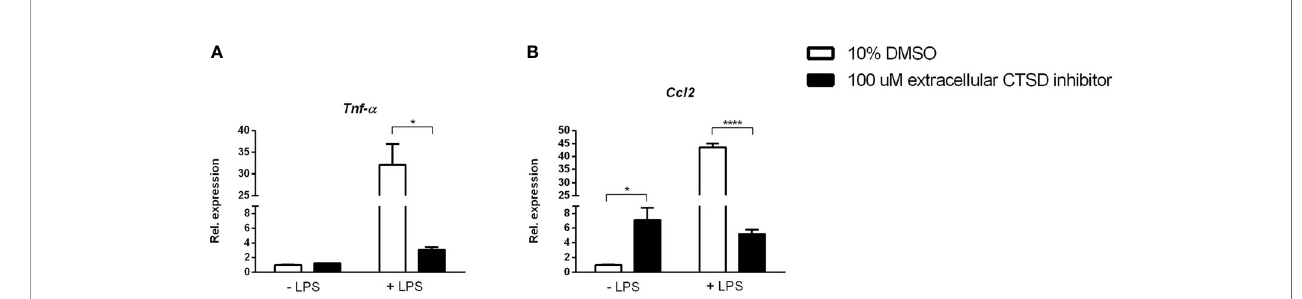
FIGURE 5 | Anti-in fl ammatory effects of extracellular CTSD inhibitor are LPS- dependent: (A, B) Gene expression levels of Tnf a , and Ccl2 from mouse Wt mouse BMDMs. Gene expression data are shown relative to DMSO-treated BMDMs with no LPS. Error bars represent ± SEM; n = 3 from an independent experiment. * represents p < 0.05 and **** represents p < 0.001 compared to DMSO-treated BMDMs as determined by two-way